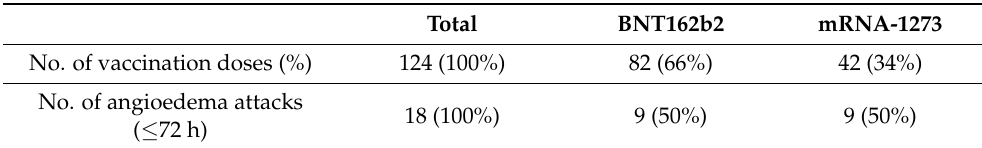
Table 6. No. and type of intramuscularly delivered vaccines as booster doses and no. of angioedema attacks following the vaccination ( ≤ 72 h).